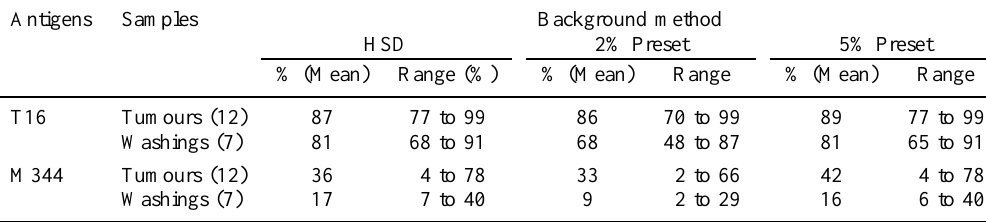
Table 1 Expression of the T16 differentiation antigen and of the M344 tumoral antigen on cells of bladder washing